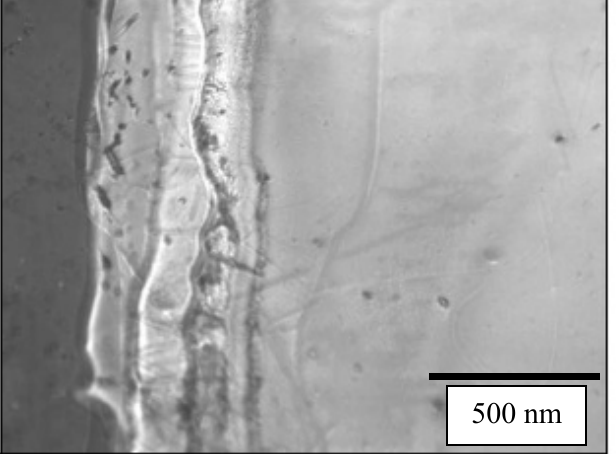
:Eu 3+ film calcined at 700 3